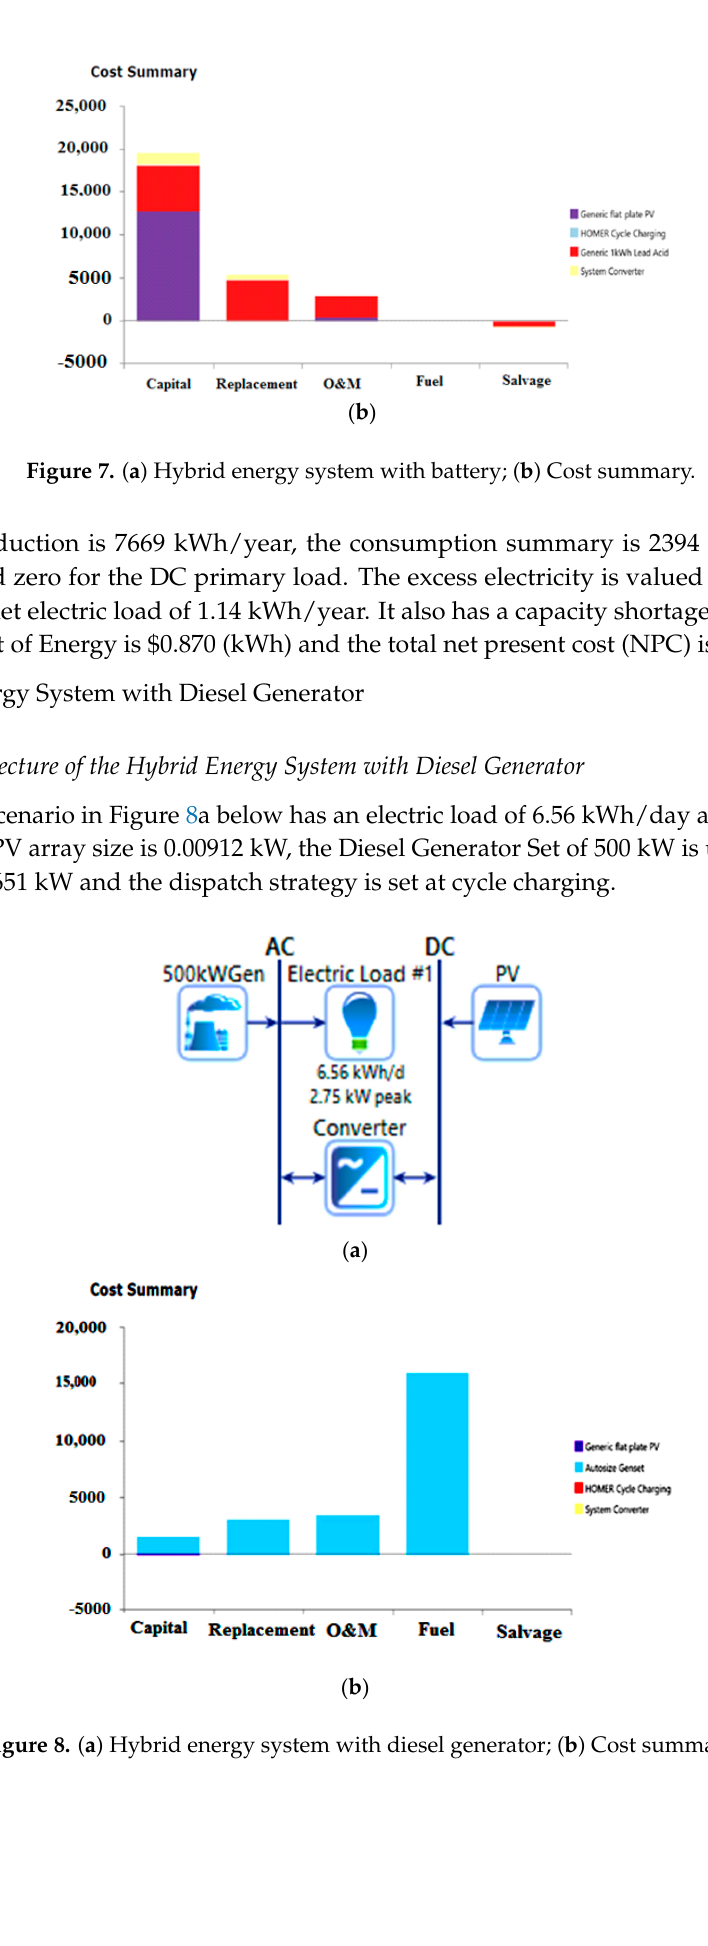
Figure 8. ( a ) Hybrid energy system with diesel generator; ( b ) Cost summary.